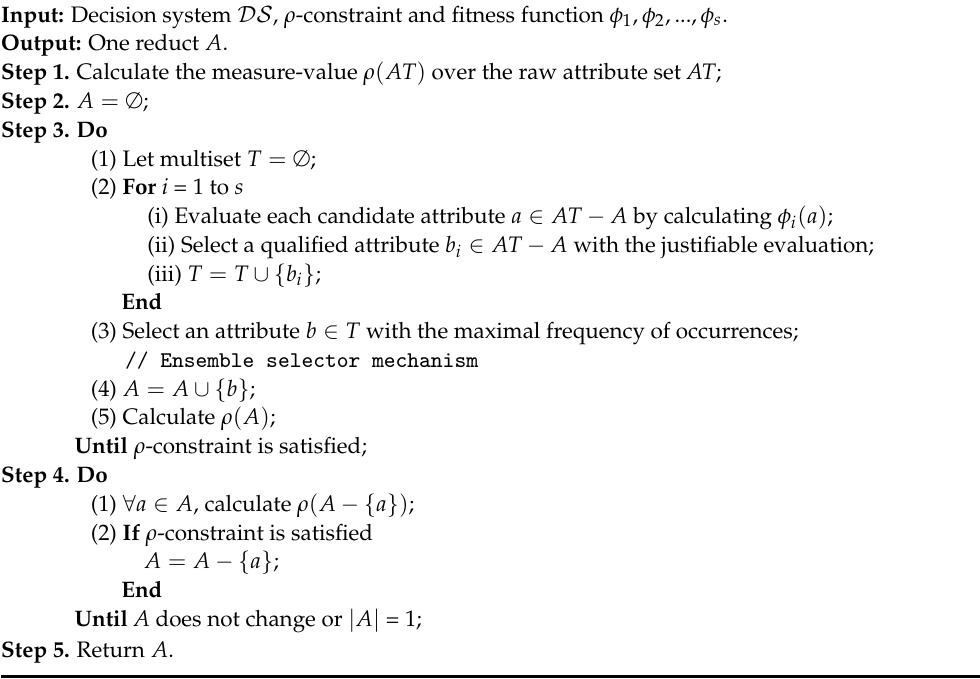
Algorithm 3. Ensemble Selector for Attribute Reduction